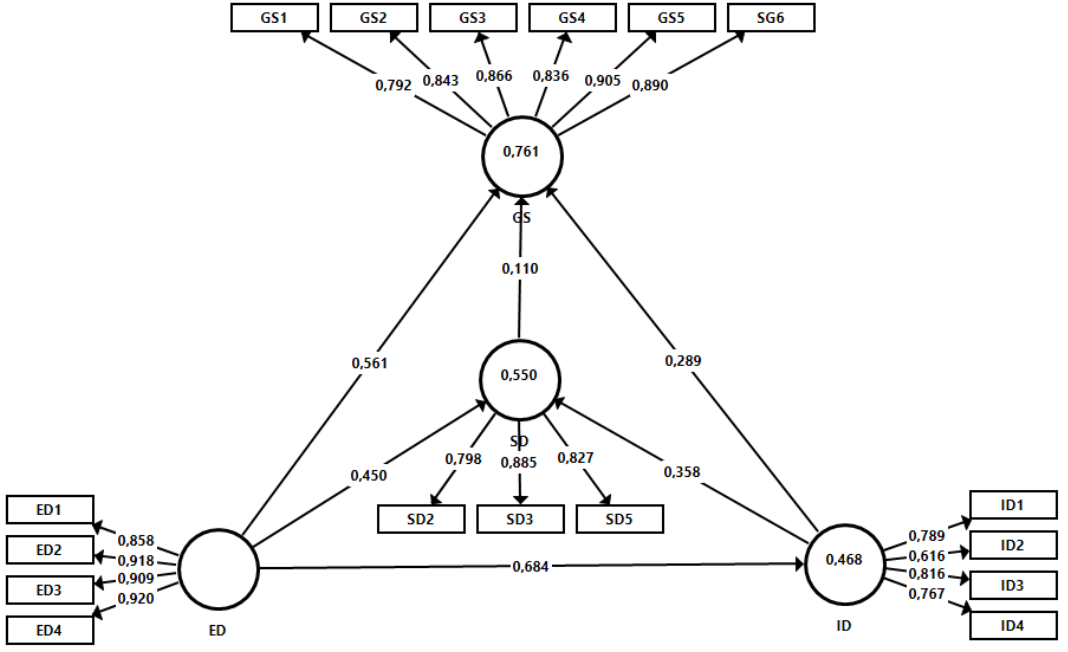
Figure 2. Estimation of the structural equation model. Table 4. Reliability